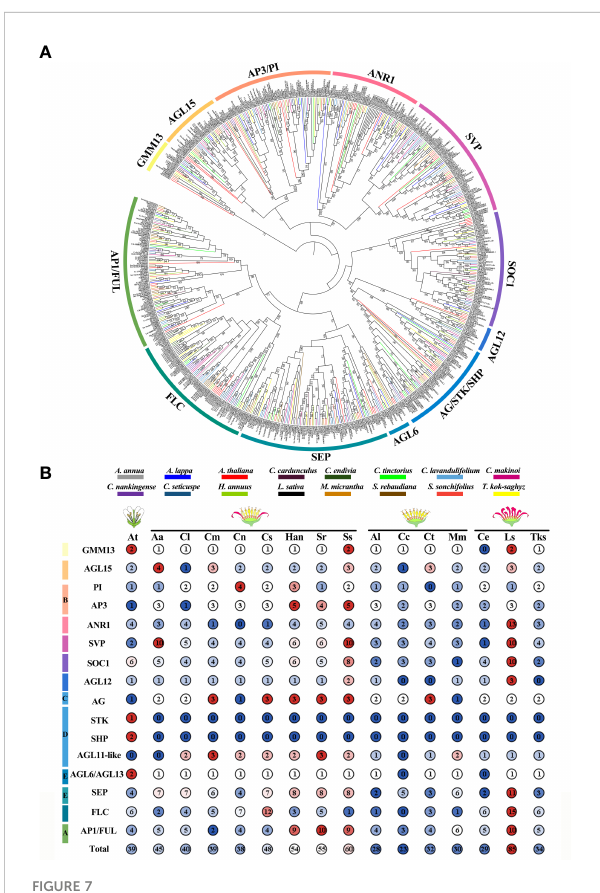
FIGURE 7 Phylogenetic analysis and statistic of MIKCc in Arabidopsis and fi fteen Asteraceae. (A) The ML Phylogenetic tree of MIKCc in 15 Asteraceae. The bootstrap replicates were 5000. The number above branches represented bootstrap value and the values below 50 would not be shown. We used different colors to distinguish species and clades. (B) The member counts of each clade of MIKCc in 16 species. Their respective in fl orescence types are indicated on the top. At, A. thaliana ; Aa, A. annua ; Cl, C. lavandulifolium ; Cm, C. makinoi ; Cn, C. nankingense ; Cs, C. seticuspe ; Han, H. annuus ; Sr, S. rebaudiana ; Ss, S. sonchifolius ; Al, A. lappa ; Cc, C. cardunculus ;